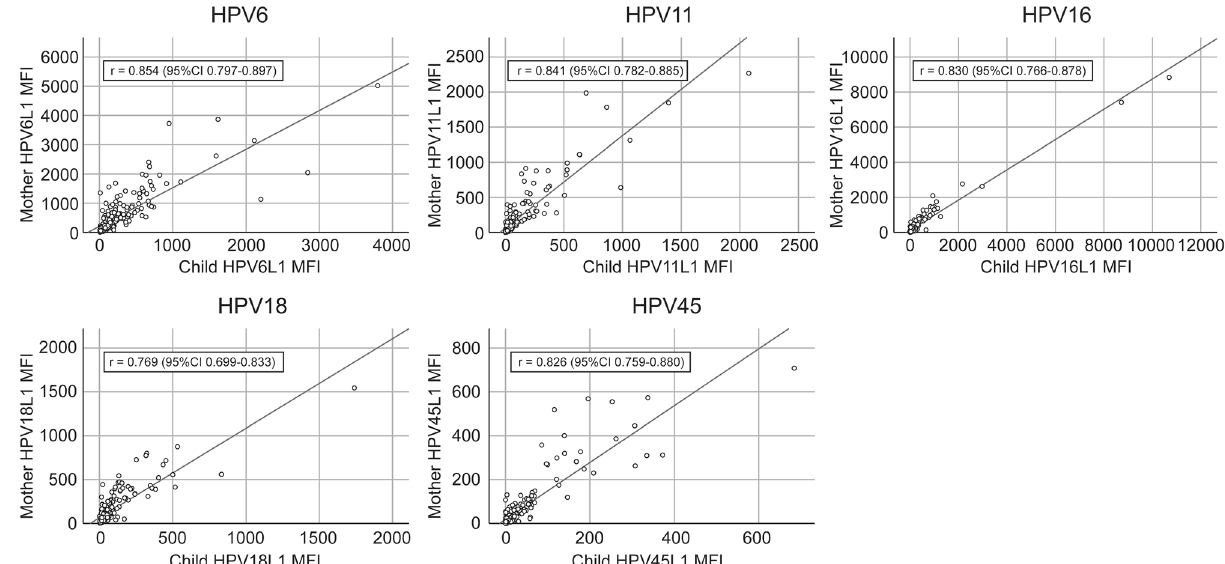
Figure 3. Correlation of antibody levels between the mothers—offspring pairs by HPV type. Correlation of individual HPV L1 serum antibody levels (MFI values) between pregnant mothers at 3rd trimester and offspring aged 1 month. None of the mothers had been vaccinated for HPV. Lines represent linear regression analyses; r Spearman coefficient, MFI Mean fluorescence intensity, CI confidence interval.